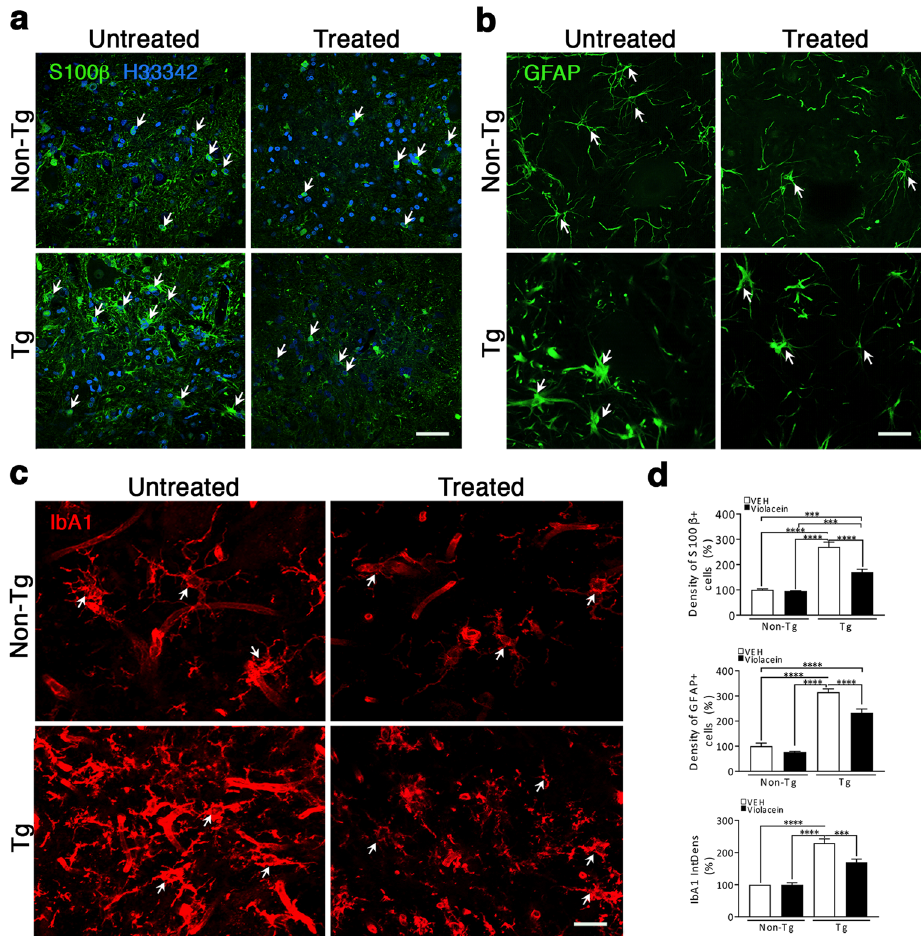
Figure 7. Very low glial reactivity in the spinal cord of Tg-treated animals. ( a ) Representative confocal Z-stack images of S100β immunofluorescence (green) in each experimental condition. Whereas in Non-Tg images, S100β appeared surrounding the nucleus, there was an increased density of positive swollen cells with coarse processes in Tg-untreated rats. Violacein treatment modulated both the number and appearance of S100β positive cells in the Tg-treated condition. Hoechst 33342 stained cell nuclei (blue). ( b ) Representative Z-stack images of GFAP immunofluroescences in all experimental conditions. Non-Tg and Tg-treated images exhibited delicate positive cell processes whereas in Tg-untreated rats there was a predominance of GFAP positive swollen cells with gross and short positive processes. ( c ) Confocal Z-stack images of the microglial cell marker Iba1 in all experimental conditions. Images from Non-Tg and Tg-treated sections showed positive cells with thin processes whereas in the Tg-untreated image there was an increased signal mostly present in swollen cells with short and coarse processes. Blood vessels were delicately positive to Iba1 . For each marker analyzed (( a ), ( b ) and ( c )), white arrows point positive cells representative of each experimental condition. Calibration: 100 µm, 40 µm and 20 µm for ( a ), ( b ) and ( c ), respectively. ( d ) Quantitation of S100β, GFAP and Iba1 cellular density related to Hoechst 33342 positive cells indicated that Tg-untreated versus Non-Tg samples had increases in S100β (p < 0.0001), GFAP (p < 0.0001) and Iba1 (p < 0.0001), respectively. Violacein caused less but yet significant increased values in Tg-treated versus Non-Tg conditions as indicated by S100β (p < 0.0001), GFAP (p < 0.0001) and Iba1 (p < 0.0001), respectively. In all cases, quantitation was done by measuring the cells that co-localized with Hoechst 33342 positive cell nuclei. Hoechst 33342 signal was omitted to emphasize violacein modulation of GFAP and Iba1 immunoreactivity in ( b ) and ( c ),